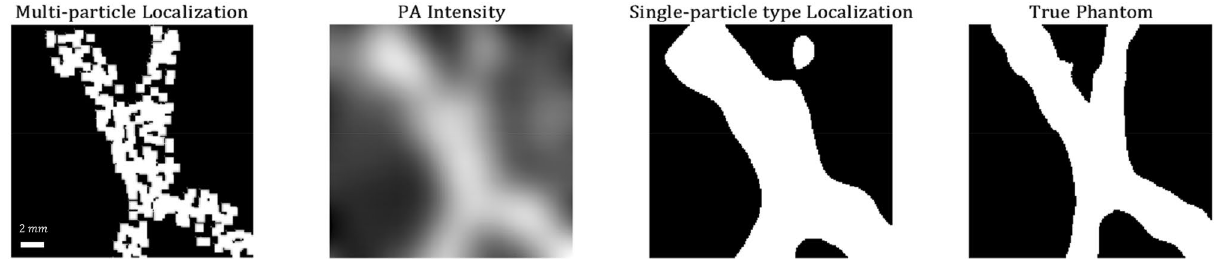
Figure 4. Imaging results. On the right, an image of the true 2 vessel phantom (the white area describes the area injected with particles). The second image from the right presents the localization-based image, not considering the various particle types. The second image from the left is the image reconstructed using photoacoustic intensity regardless of particle type (the traditional reconstruction scheme). The leftist image describes the multi-particle image reconstruction presented in this work.